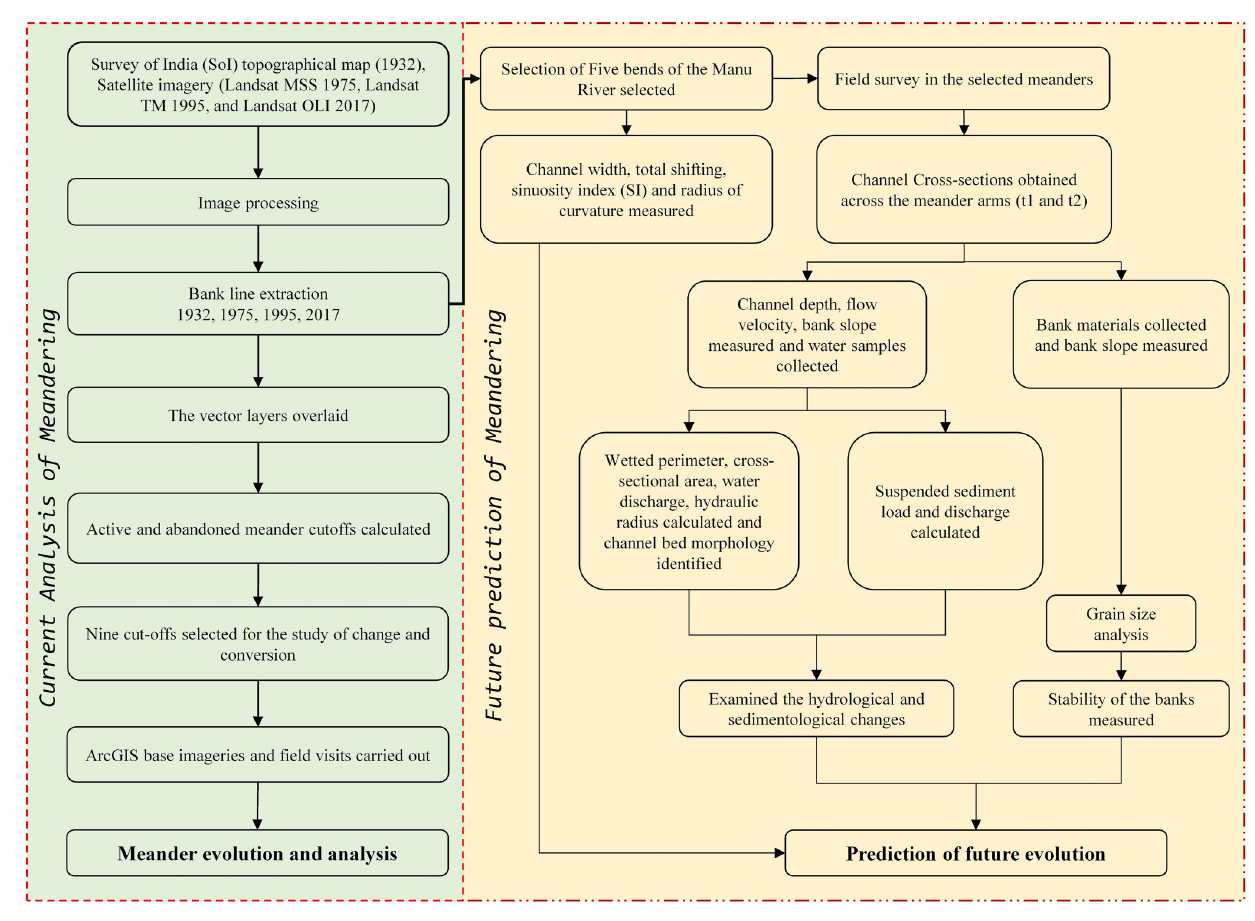
Fig 4. Conceptual framework of the methods